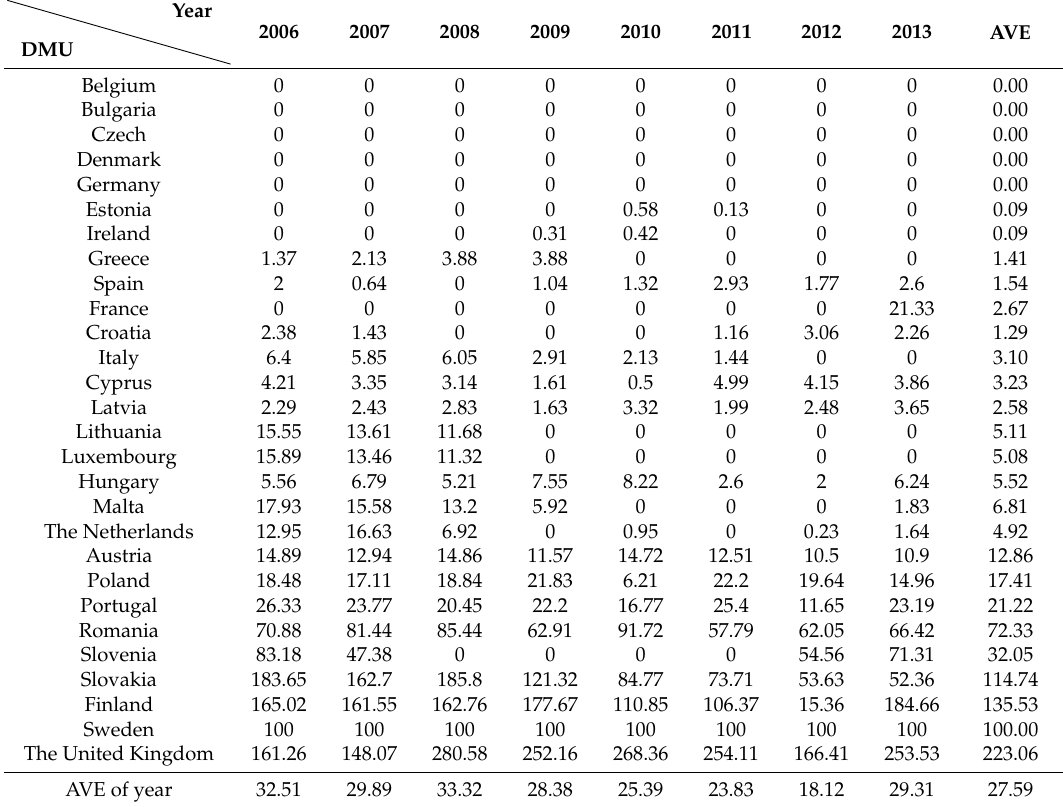
Table 10. Adjustment percentage of GHG in EU countries. Unit: